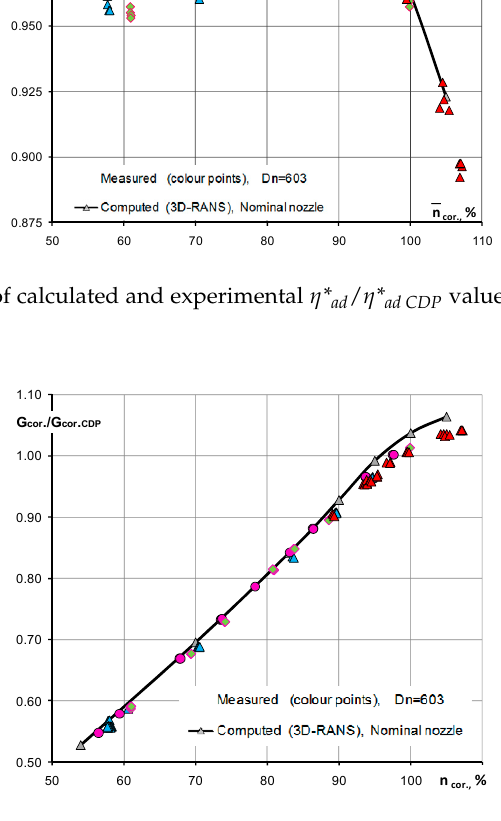
Figure 12. Comparison of calculated and experimental G cor / G cor CDP values along operating line at CDP ( n cor = 95%).